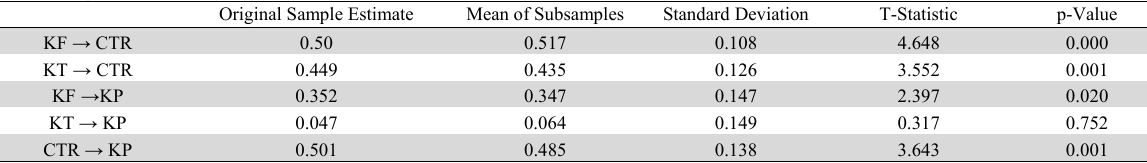
Fig. 2. Diagram of Path Coefficient and Hypotheses Examination Source: PLS Processed Result in 2016 (Appendix 6) Inner Weight (Structural